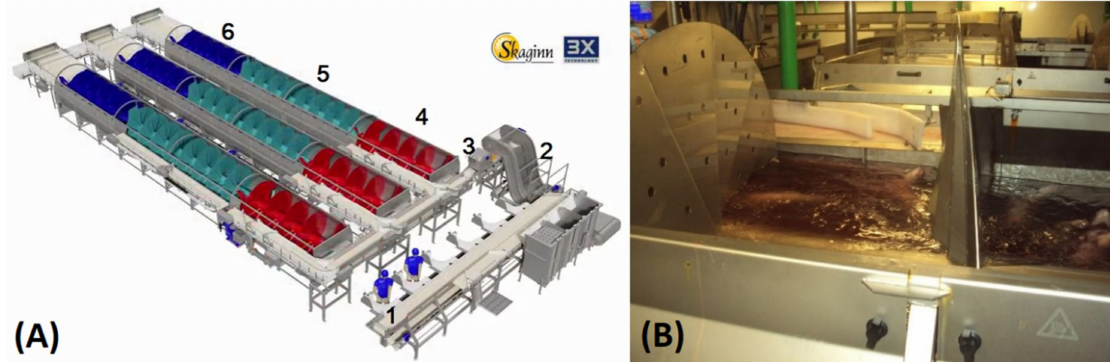
Figure1. ( A )Three-dimensionalmodelofscrewconveyorusedforcontrolledbleedingandsuperchilling. Figure labels: No.1: Gutting; No.2: Washing; No.3: Grading; No.4: Bleeding; No.5: Chilling; No.6: Superchilling [23]. ( B ) Photo of screw conveyor used for controlled bleeding.